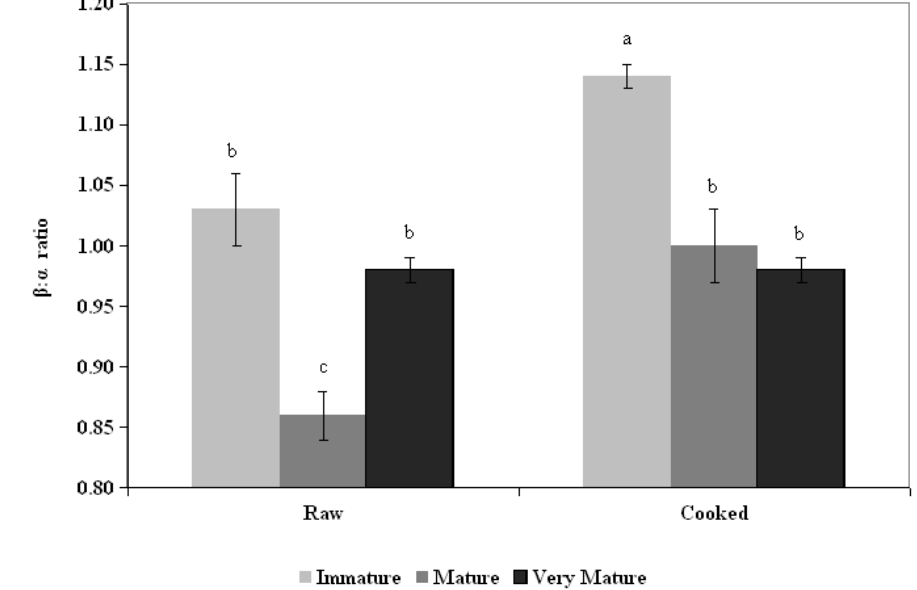
Figure 2. Relationship between β-carotene and α-carotene content, in every state of fruit maturity and preparation. Mean ± SEM ( n = 3). Different letters in the column indicate that the treatments are statistically different. Main effects: state of maturity (SM) < 0.0001; Preparation ( p ) < 0.0001; SM × p =